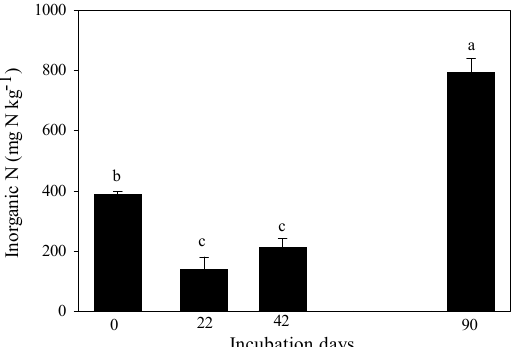
Figure 3. Mean average values of soil inorganic N content from 0 to 90 days of incubation. Vertical lines represent the standard errors and lower case letter represents difference between the incubation days.